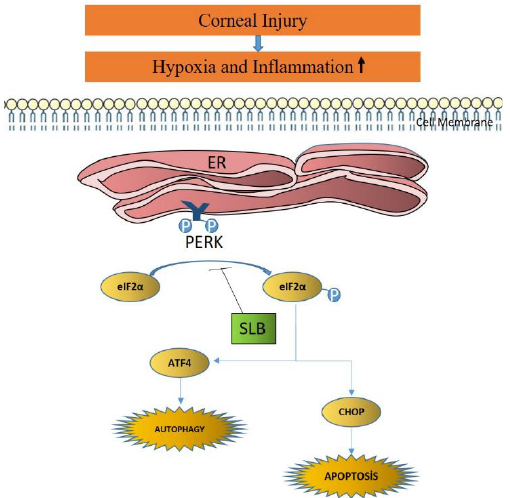
Figure 1. ER stress-mediated apoptosis pathway under corneal injury. Under hypoxic state, PERK involve in apoptosis via eIF2α. The hallmark event is the progressive accumulation of misfolded protein aggregates. Apoptosis is a genetically programmed process aimed at eliminating damaged cells by activation of caspases. The process is activated either by TNFR stimulus extracellularly or intracellularly mainly by nonreceptor stimuli such as DNA damage, ER stress, metabolic stress, UV radiation, or growth factor deprivation. Autophagy, on the other hand, is a cellular catabolic pathway involving protein degradation, organelle cycling, and nonselective degradation of cytoplasmic